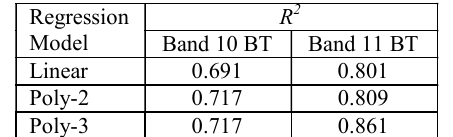
Table 4. Statistical Information of in situ data